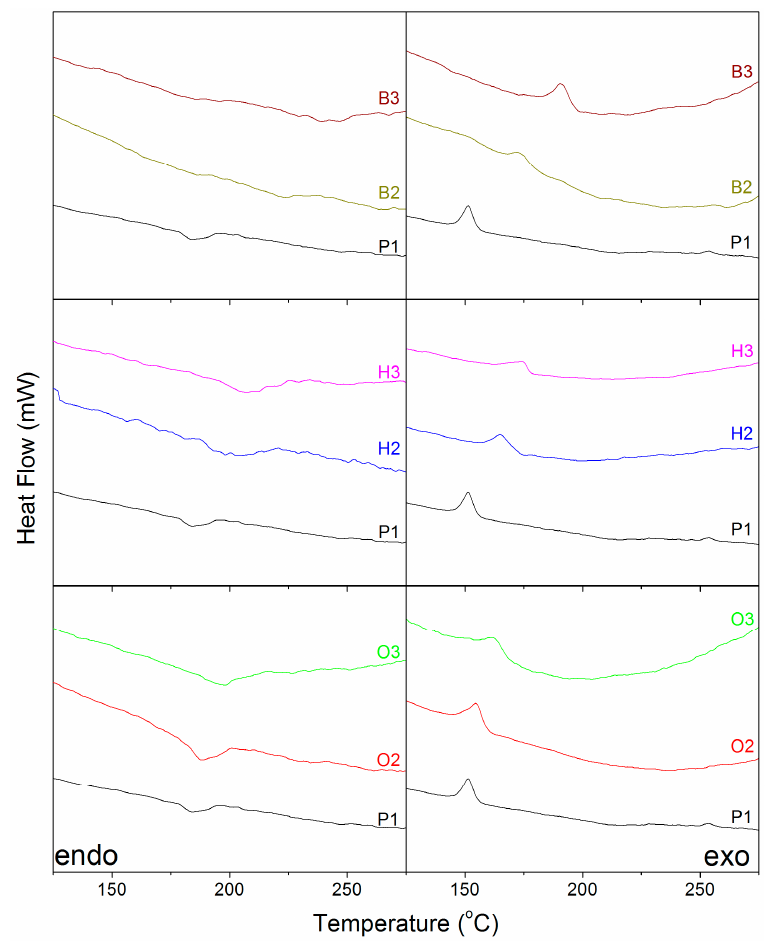
Figure 2. DSC plots of the synthesized copolymers. Table 2. Thermal properties of